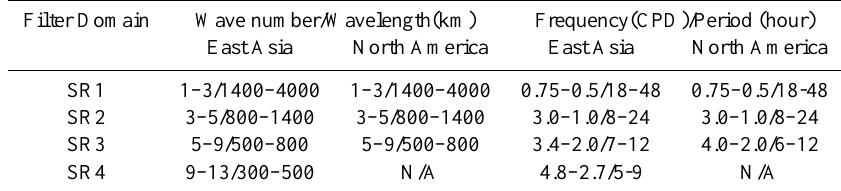
Table 1. Wave-number-frequency filter domains shown in Fig.9b and d. Filter Domain